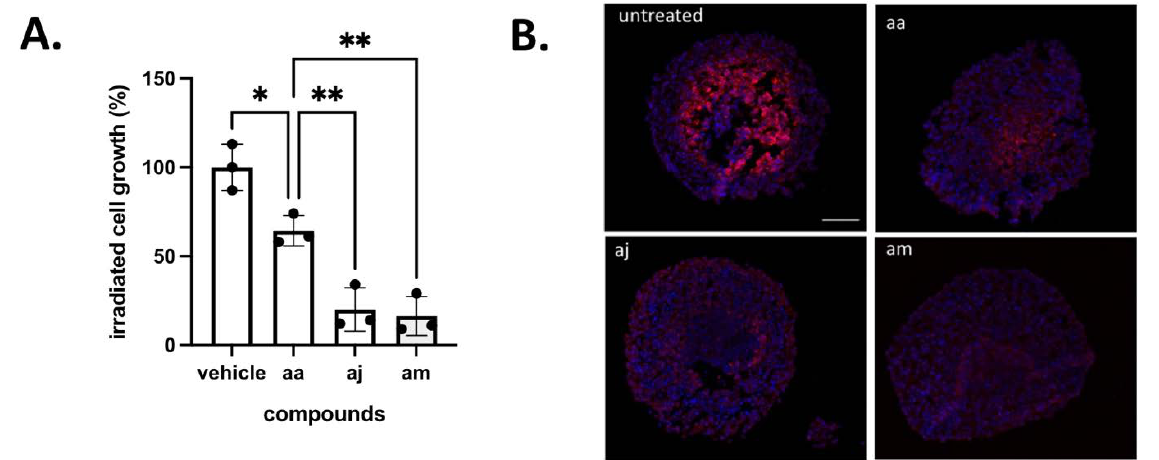
Figure 6. Radiosensitizing effects of selected complex I inhibitors. ( A ) Extent of surviving cancer cells post-exposure to radiotherapy and the indicated compounds (n = 3, * p < 0.05, ** p < 0.01 vs. vehicle condition). ( B ) Representative pictures of pimonidazole immunostaining revealing a reduction in the hypoxic fraction of 3D tumor CT26 spheroids induced by the indicated compound; this experiment was repeated twice with similar results.